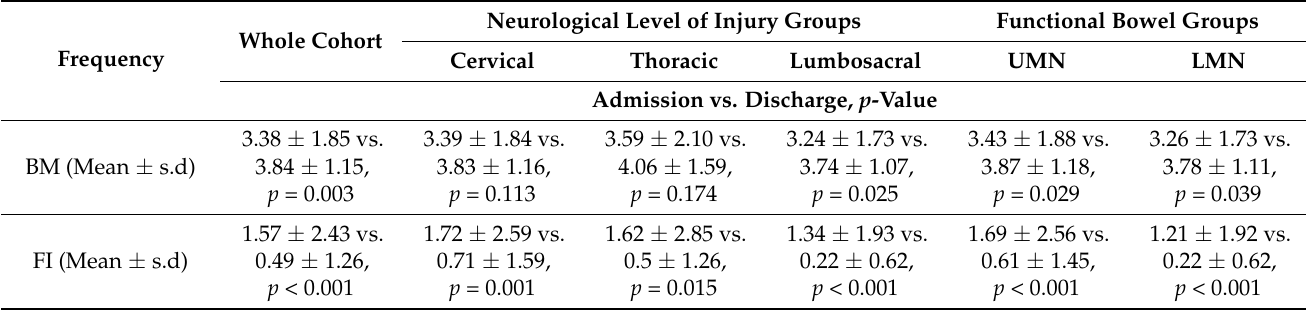
Table 2. Change in bowel dysfunctions from admission to discharge in individuals with SCI during acute rehabilitation. Neurological Level of Injury Groups Functional Bowel Groups Whole Cohort Frequency Cervical Thoracic Lumbosacral UMN LMN Admission vs. Discharge, p -Value BM (Mean ±